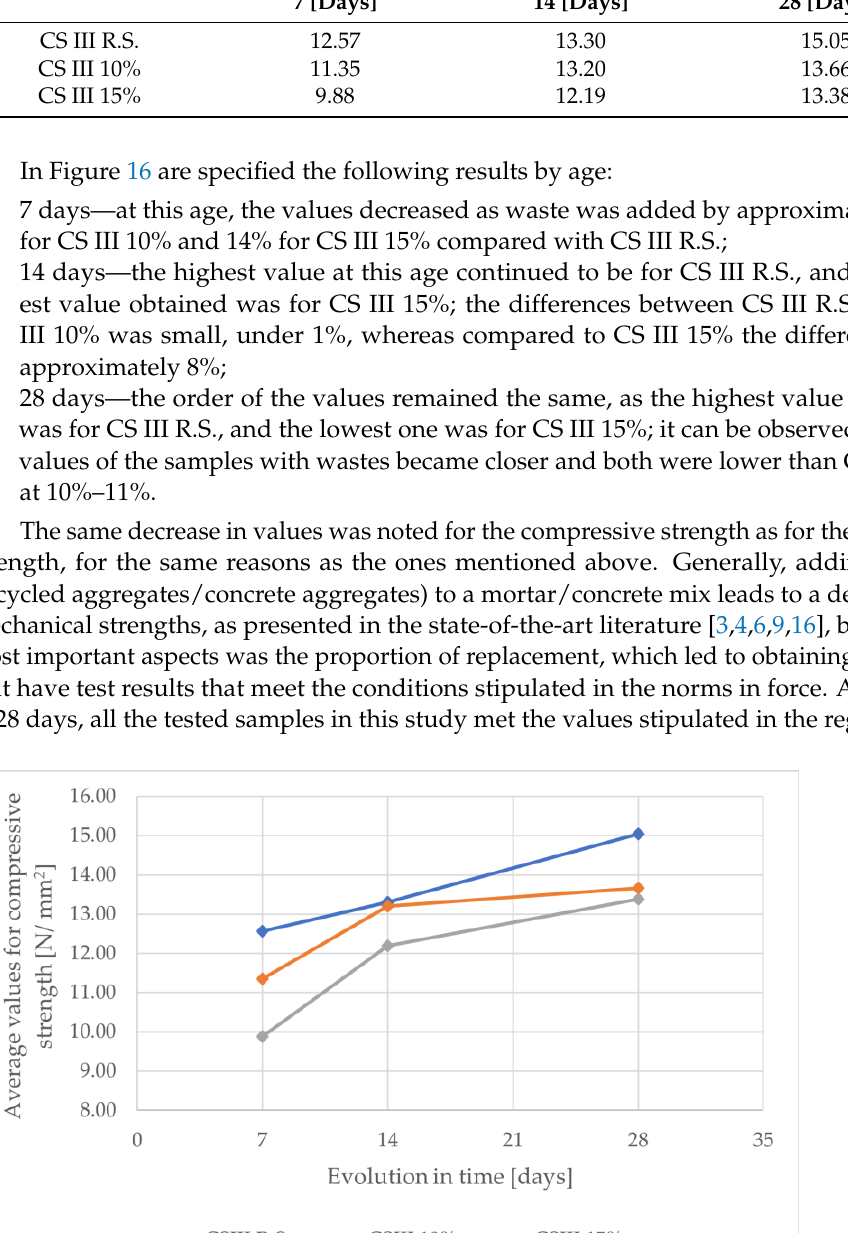
Table 9. Results for adhesion to the support layer on hardened mortars .